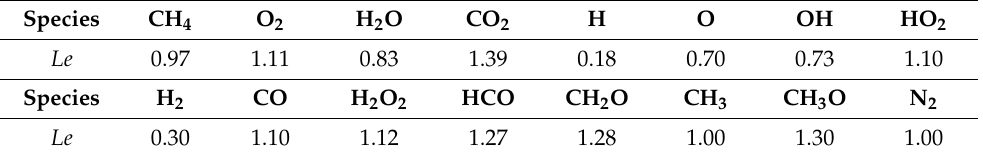
Table 3. Lewis numbers of all species [17].